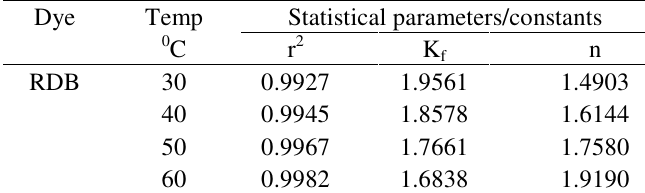
Figure 4 . Freundlich adsorption isotherm for the adsorption of RDB by PSC Table 5. Freundlich isotherm